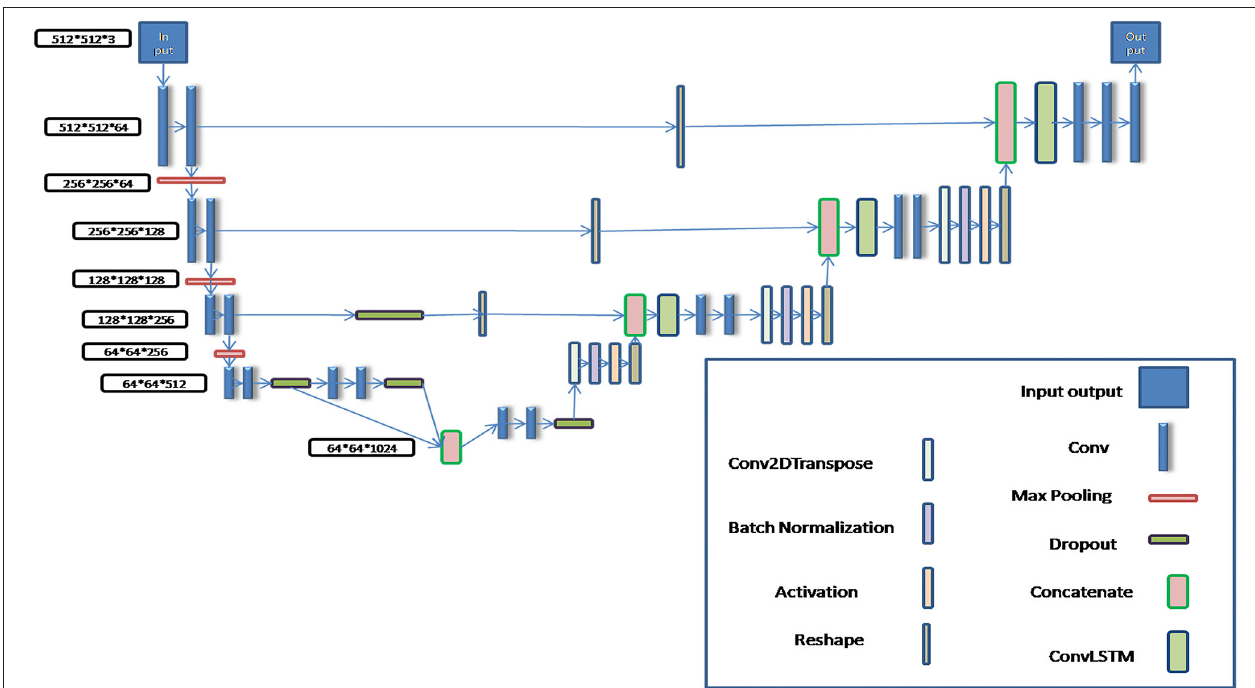
FIGURE 1 | The schematic diagram of the modified BCDU-Net